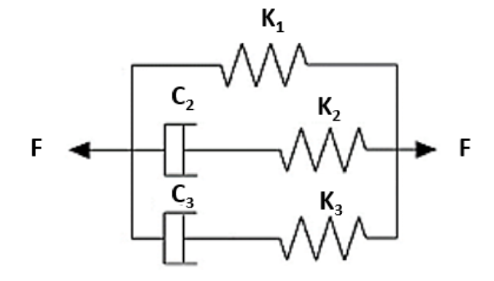
Figure 4. Schematic of Maxwell–Wiechert